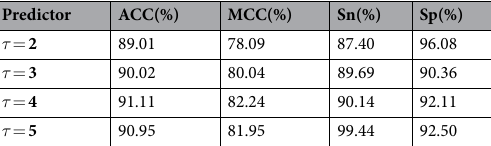
Table 2. The test results of splice acceptor site sequences based on different characteristic parameter τ values.